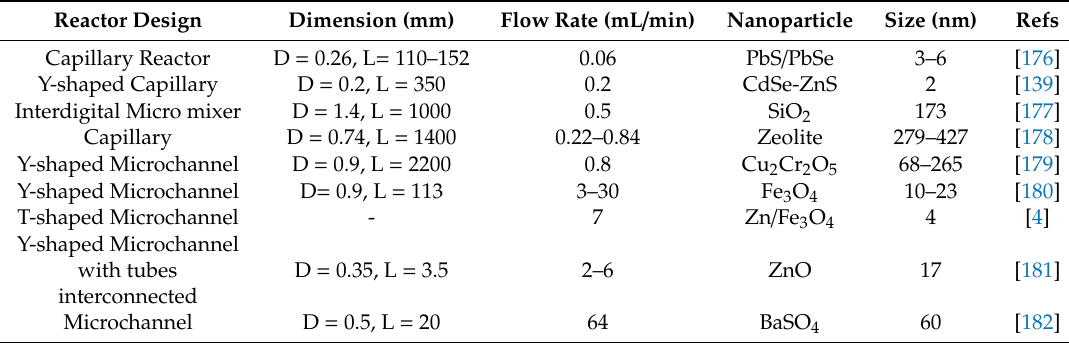
Table 3. Nanoparticle synthesis with di ff erent reactor